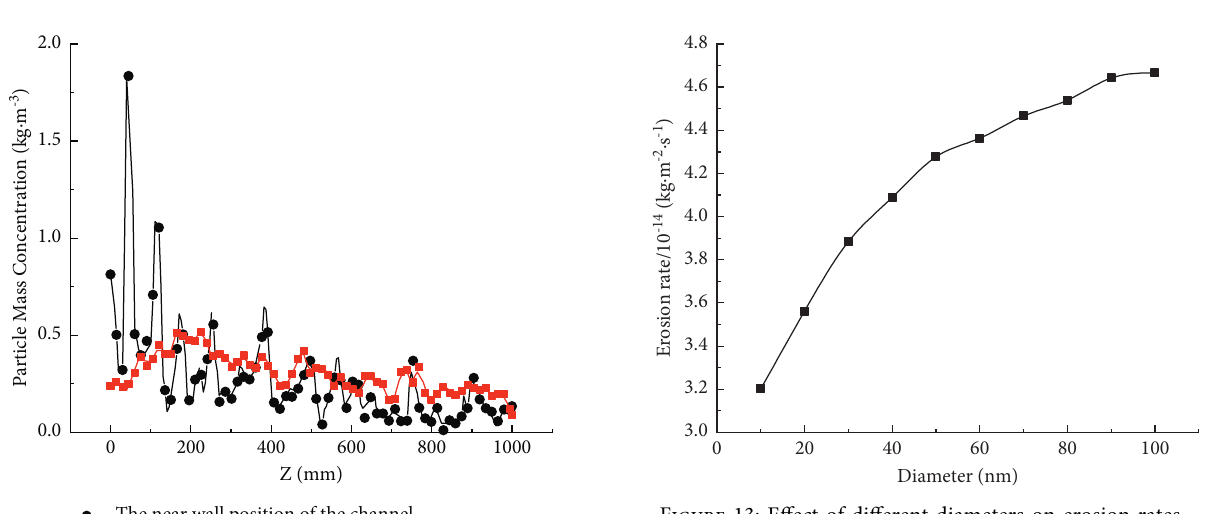
Figure 13: Effect of different diameters on erosion